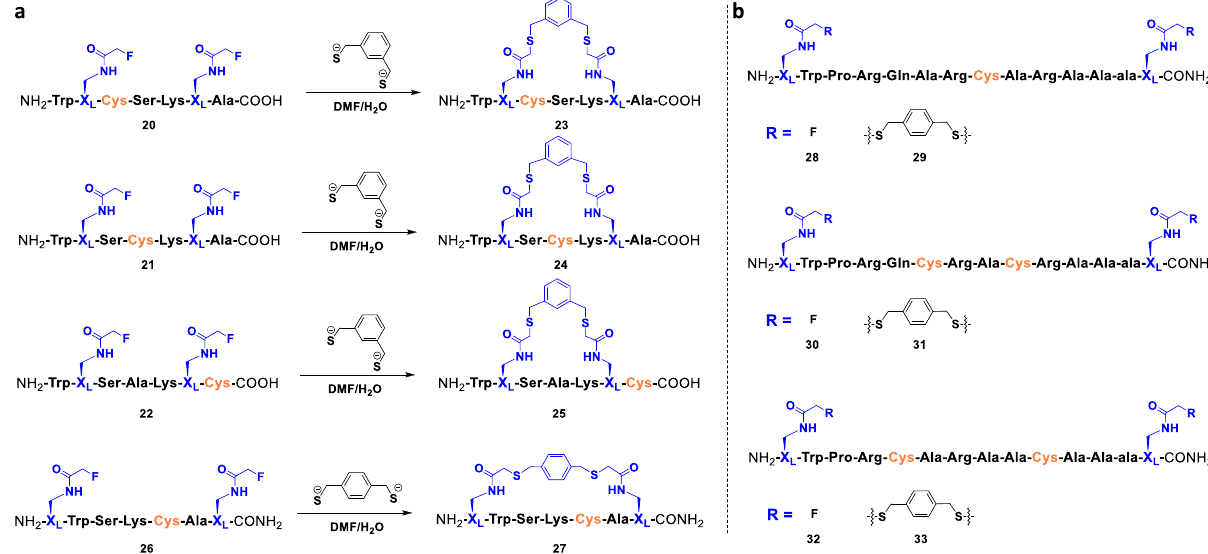
Fig. 2 FTDR-based coupling with cysteine-containing model peptides. a FTDR-based macrocyclization reactions on model peptides 20 – 22 and 26 which have cysteines and X L at different positions. b FTDR-based stapling of peptides ( 28 , 30 , and 32 ) which consist of internal cysteines at varied positions and terminal X L s. The commercially available linker benzenedimethanethiol was used for these series of model cyclization and stapling reactions, and the fi nal reaction pH was 9.0 – 9.5. Cysteine is highlighted in orange and X L is highlighted in